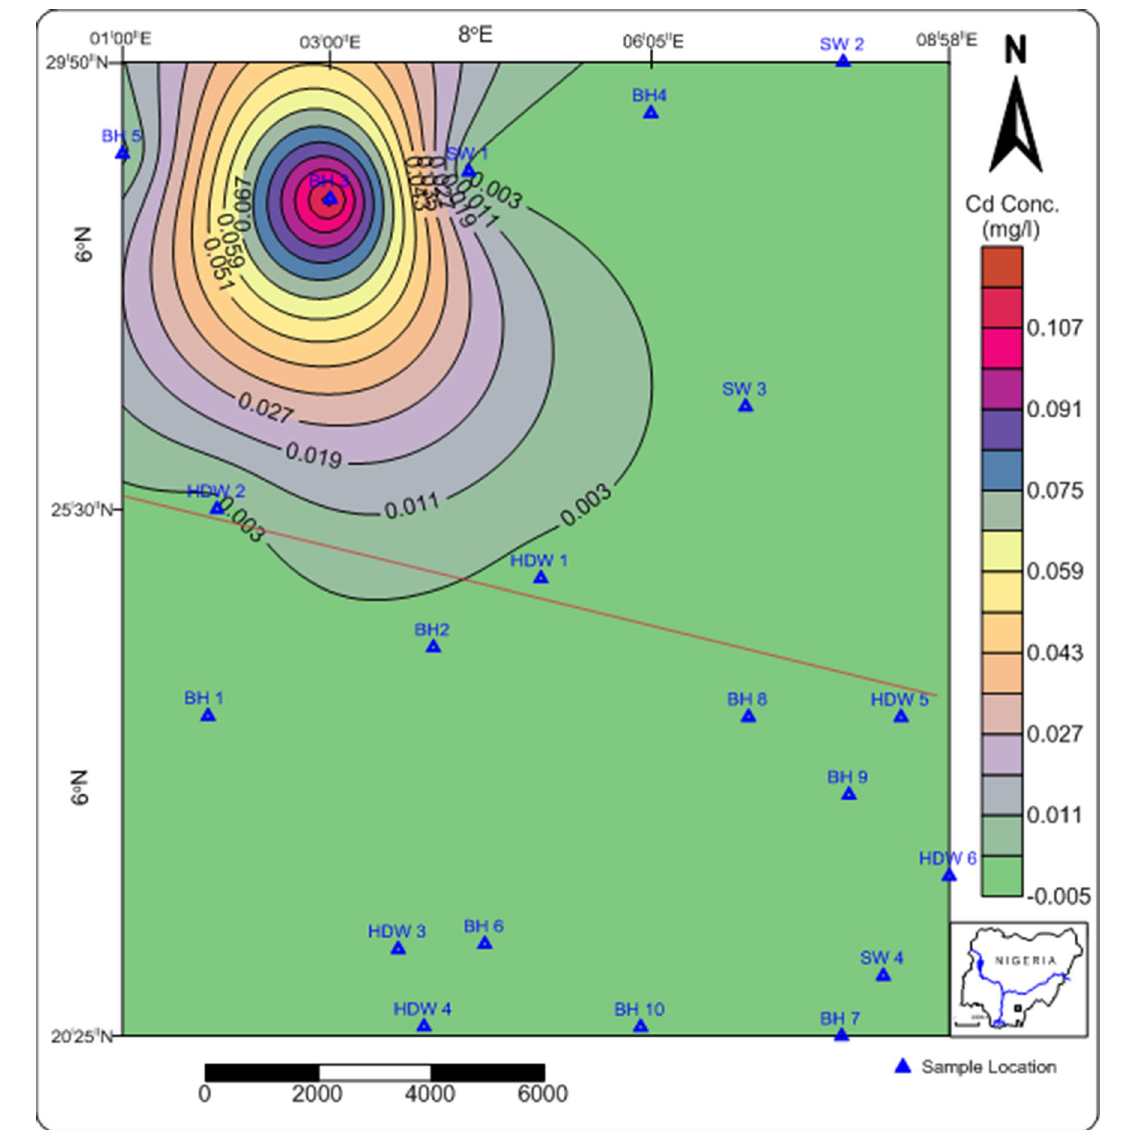
Fig. 19 Dipersion map for cadmium. Note : Perpendicular line indicates groundwater